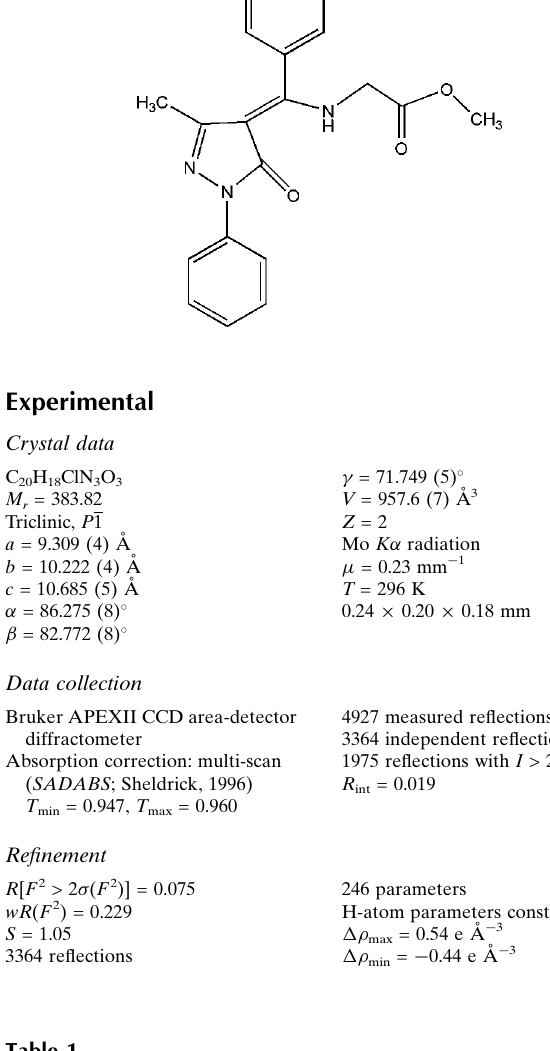
4927 measured reflections 3364 independent reflections